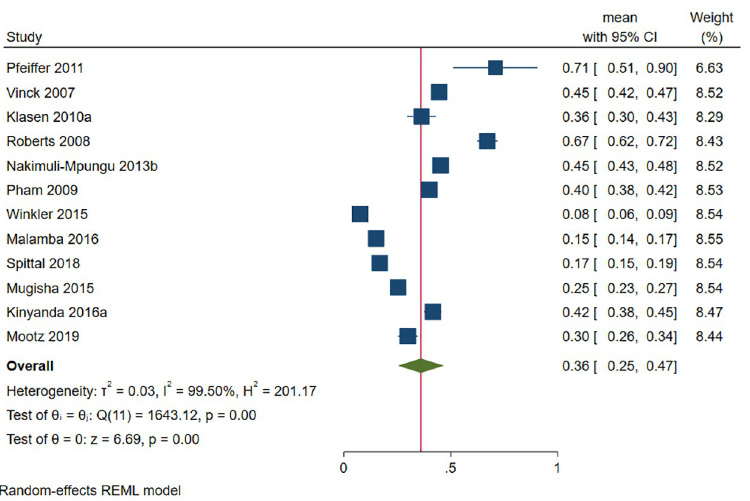
Fig 9. Forest plot on the prevalence of depression among war victims in